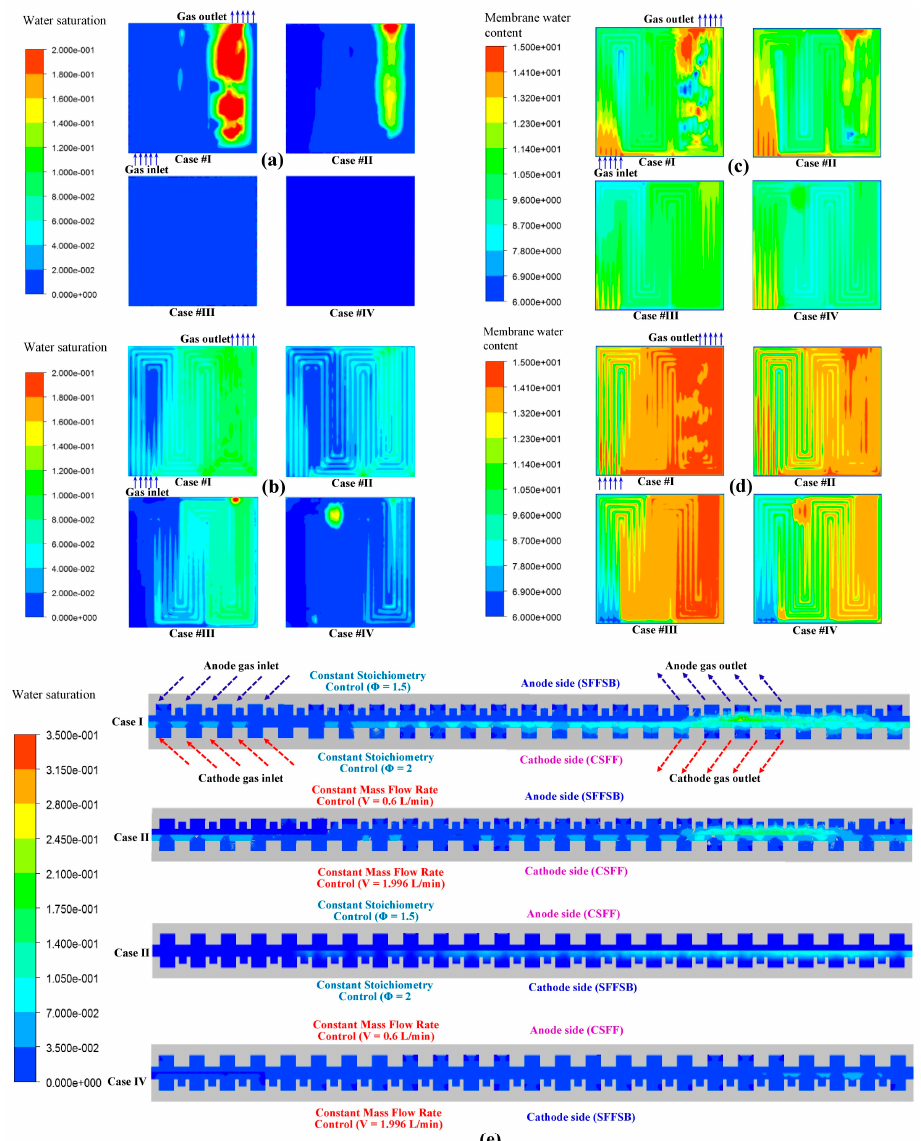
Figure 5. Comparisons of the water distributions of four simulation cases at an average current density of 1.2 A/cm 2 : ( a ) liquid water distributions at the anode side of the membrane; ( b ) liquid water distributions at the cathode side of the membrane; ( c ) anode membrane water content distributions; ( d ) cathode membrane water content distributions; and ( e ) liquid water distributions along a reference